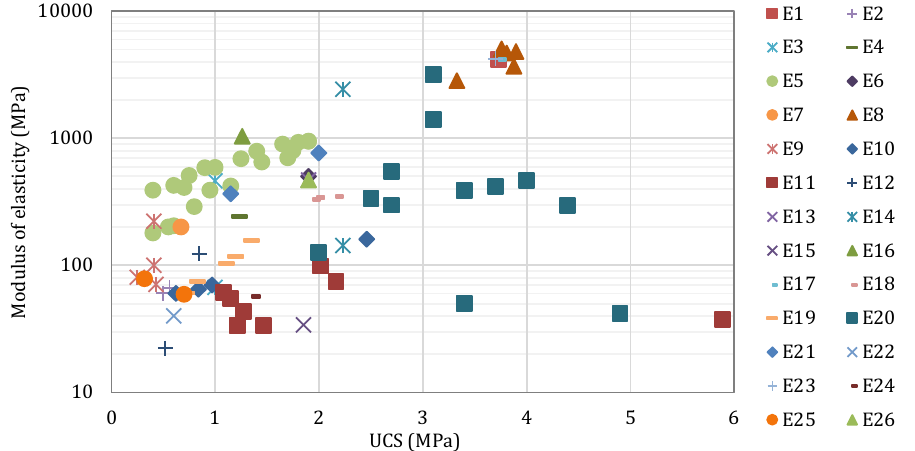
Figure 4. The relationship between UCS and modulus of elasticity: E1 [1], E2 [2], E3 [3], E4 [8], E5 [20], E6 [21], E7 [25], E8 [26,54], E9 [41], E10 [51], E11 [52], E12 [53], E13 [55], E14 [59], E15 [62], E16 [63], E17 [69], E18 [70], E19 [71], E20 [72], E21 [68], E22 [73], E23 [74], E24 [75], E25 [76], E26 [77].